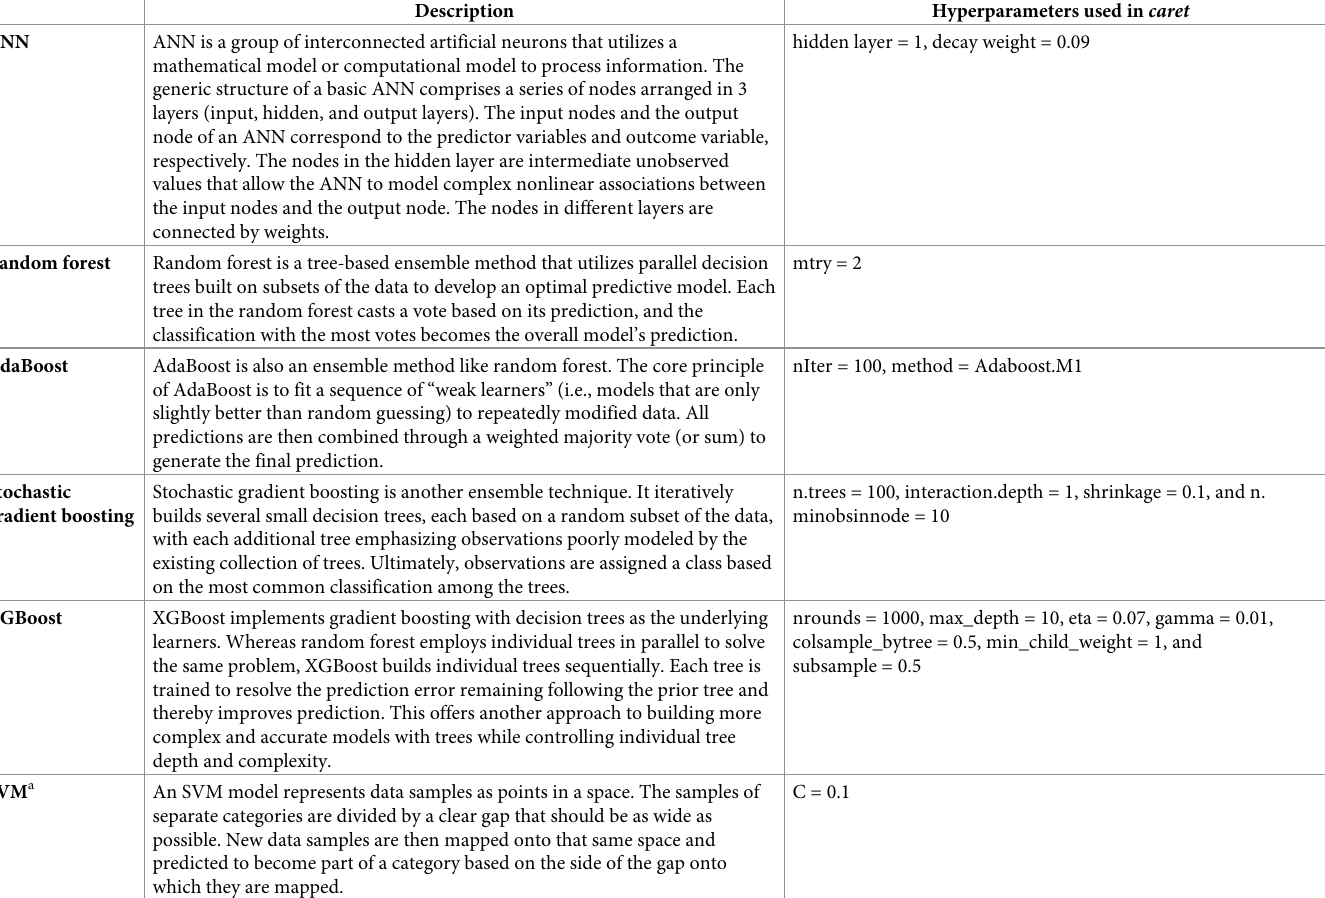
Table 1. ML algorithms used in the current study